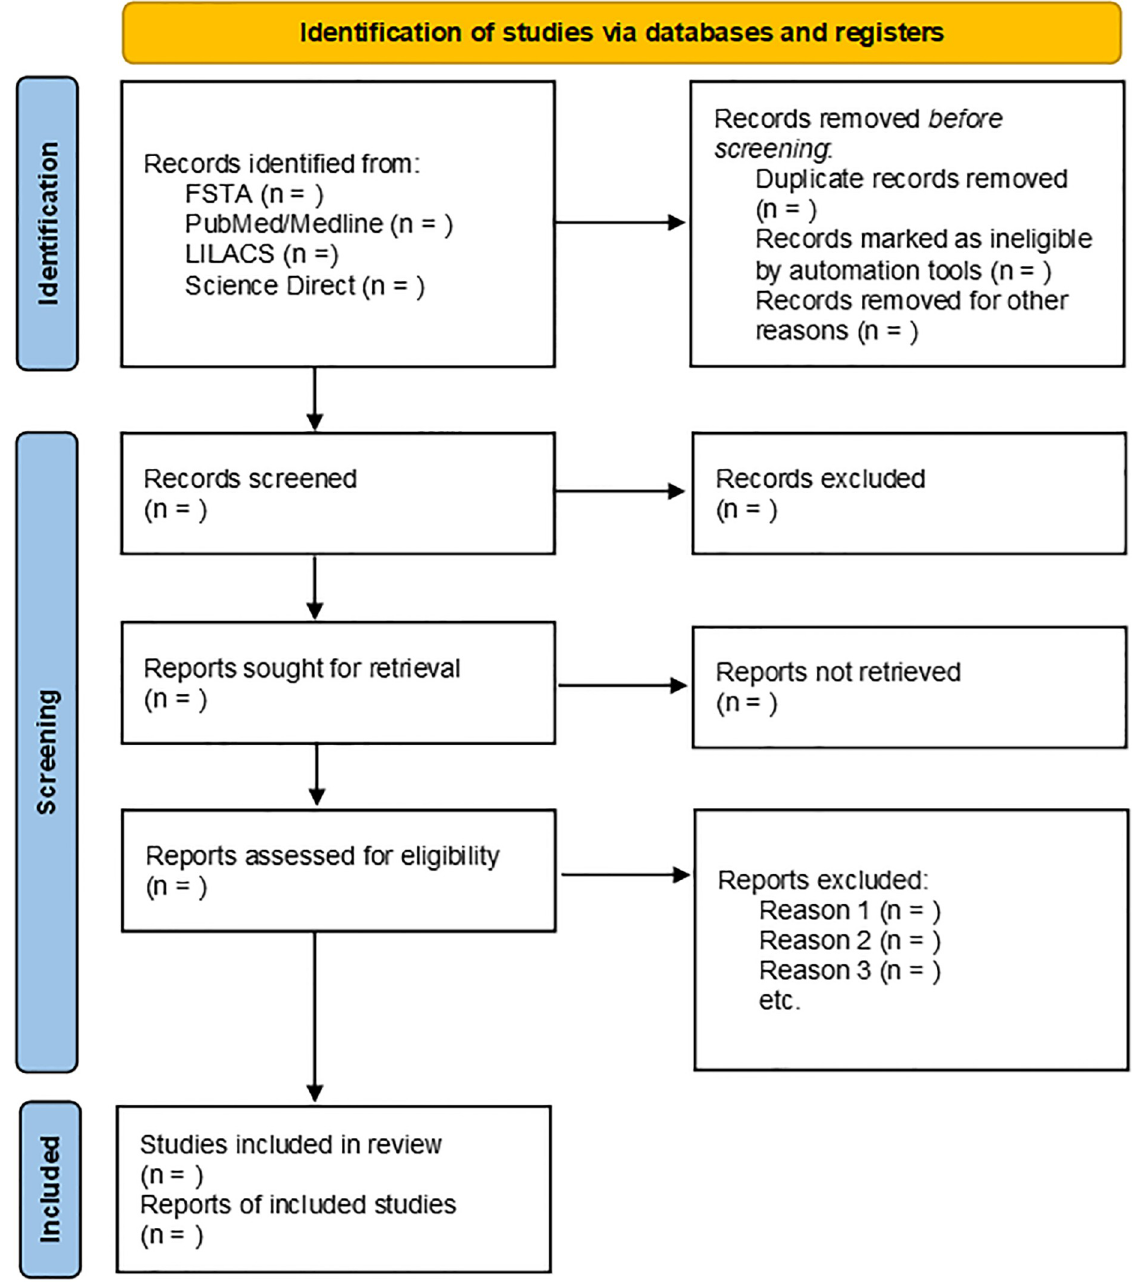
Fig 1. Flowchart of the study selection